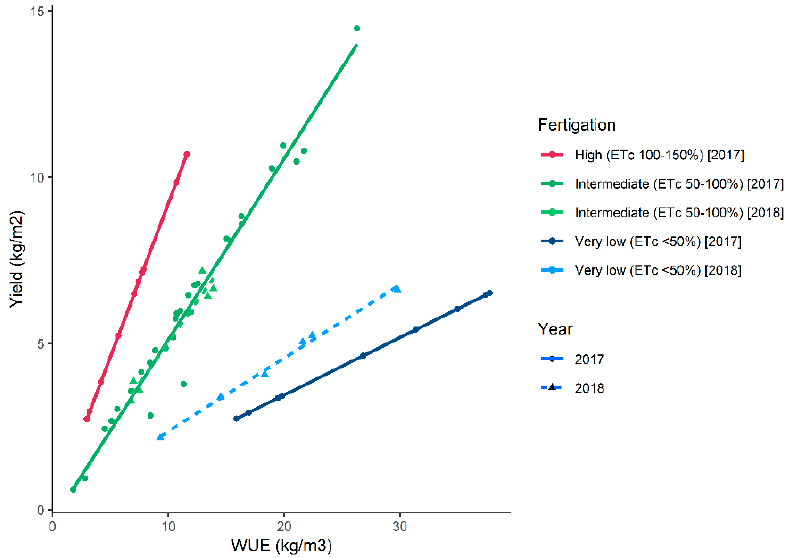
Figure 5. Patterns of water-use efficiency and yield driven by fertigation doses. Points represent the mean values per genotype and trial, and are grouped by fertigation dose (color) and year (2017, continuous line; 2018, dashed line).